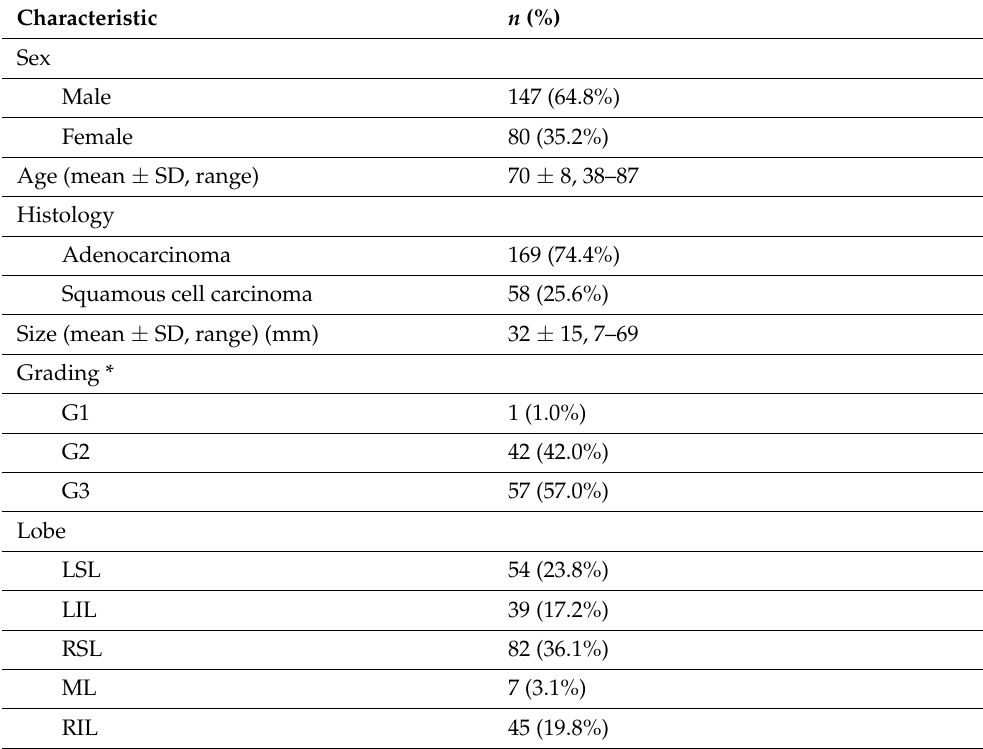
Table 1. Characteristics of the 227 patients included in the